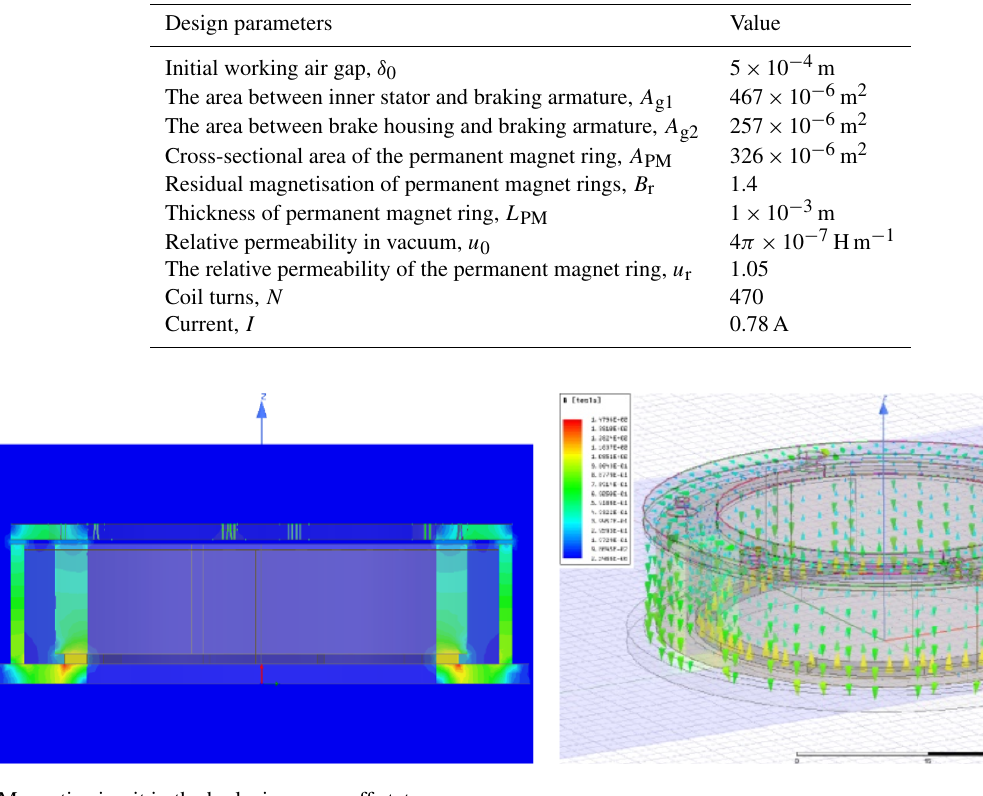
Figure 9. Magnetic circuit in the brake in power-off state.